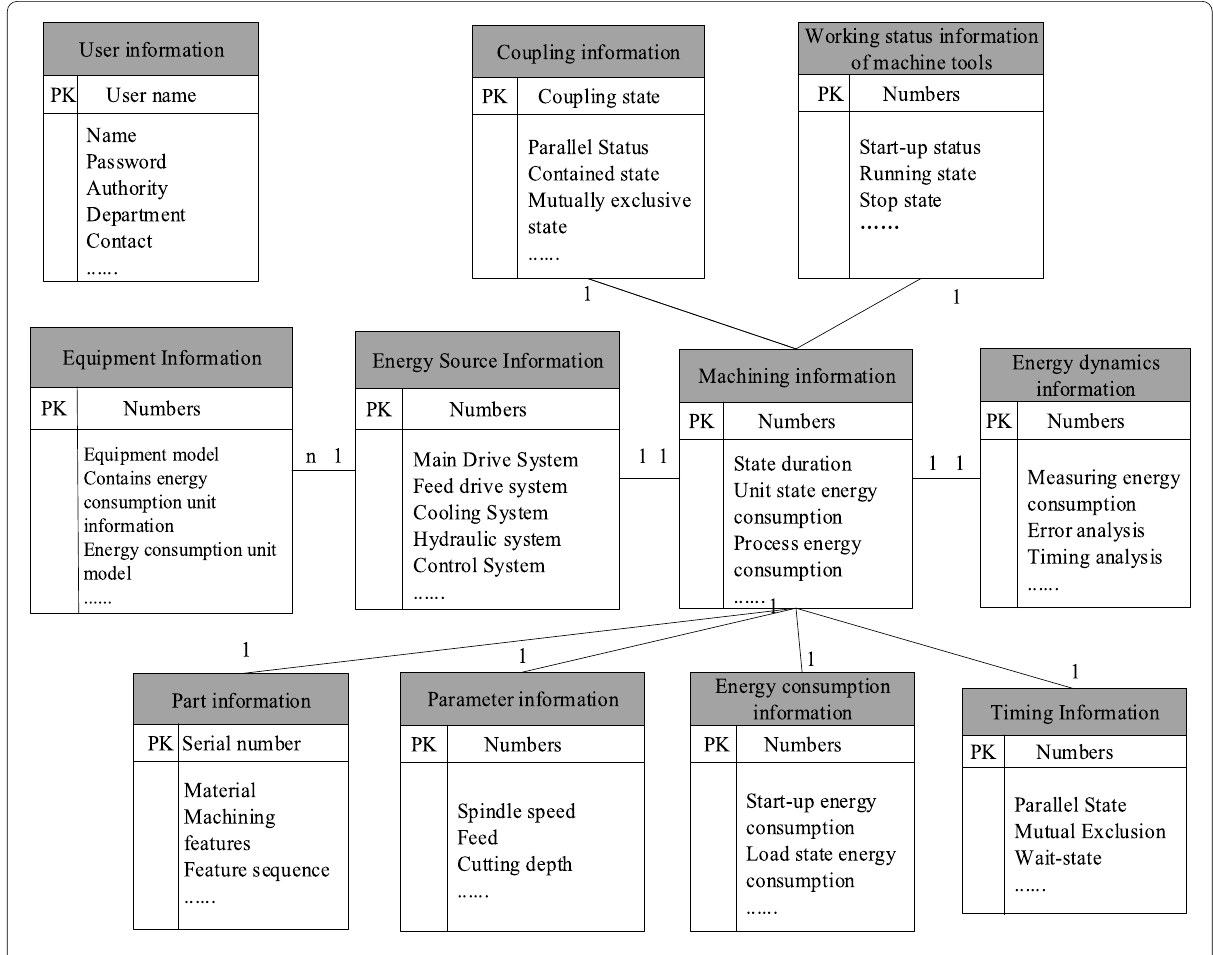
Figure 3 The correlation of data sheets